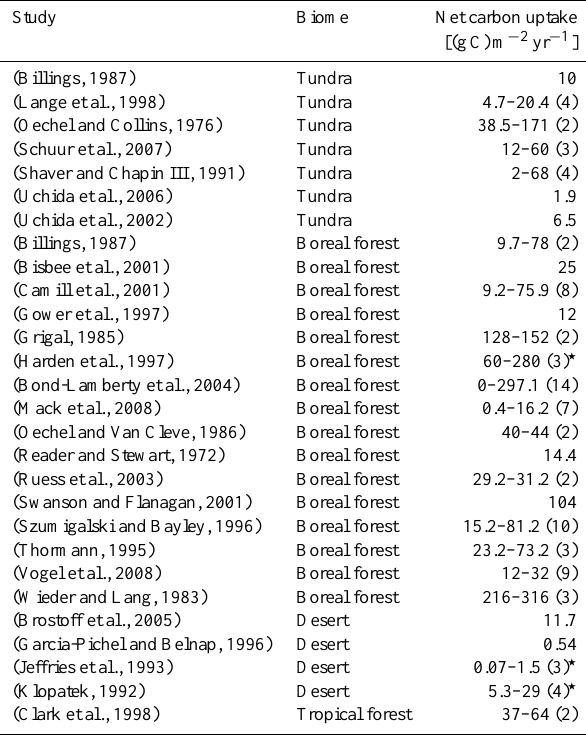
Table 1. Overview of the studies used to evaluate the model. The value in brackets in the column “Net carbon uptake” corresponds to the number of observations contained in the respective study. A ? -symbol denotes studies which provide one or more ranges instead of single values. In these cases, we calculated the mean value of the upper and lower bound of each range and show the range of these calculated mean values in the table. If net carbon uptake was reported in units of gram biomass, we used a factor of 0.4 (relative weight of carbon in CH 2 O) as a conversion factor for